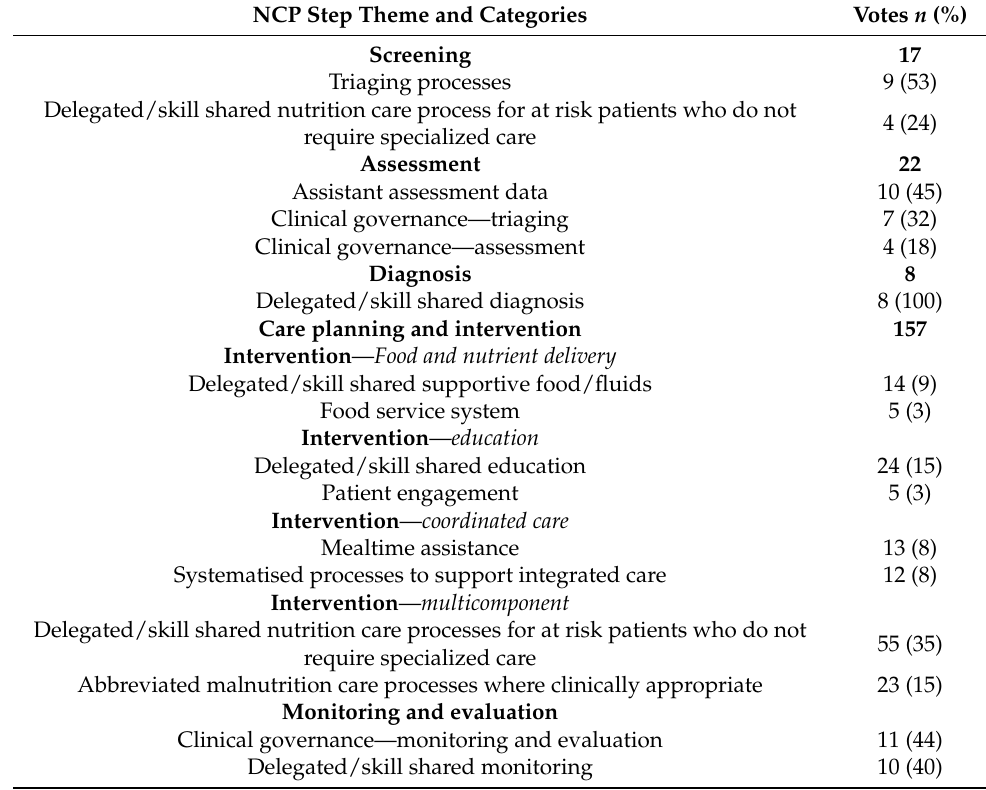
Table 5. Systematised interdisciplinary alternatives